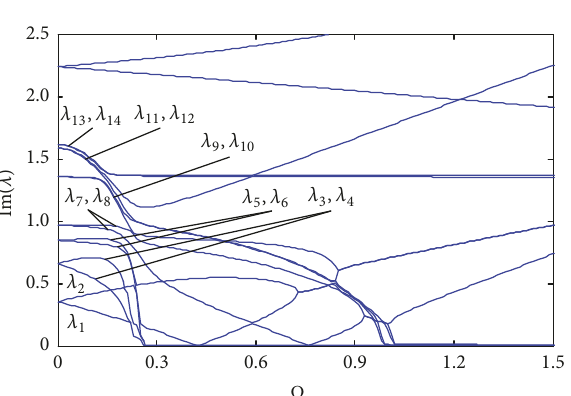
Figure 6: Imaginary and real parts of the eigenvalue for the range outlined in a dashed box in Figure 5.